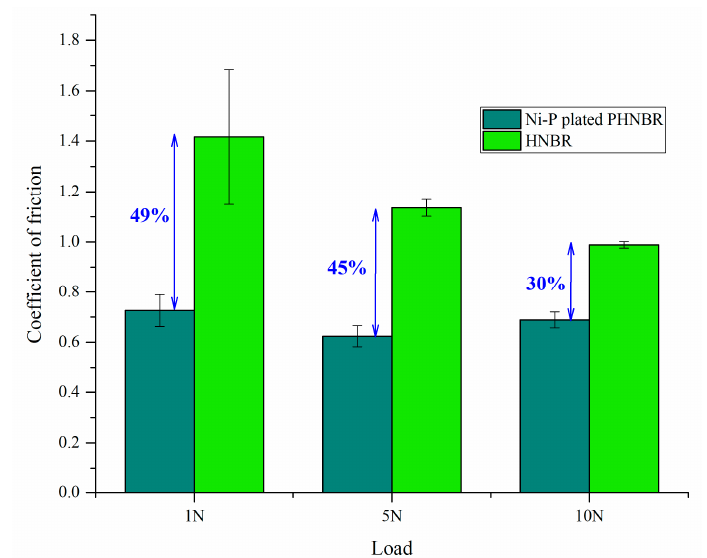
Figure 14. Mean and standard deviation of the CoF for the last 1000 cycles of the pin-on-disc test for pristine HNBR and Ni-P plated PHNBR for each load.